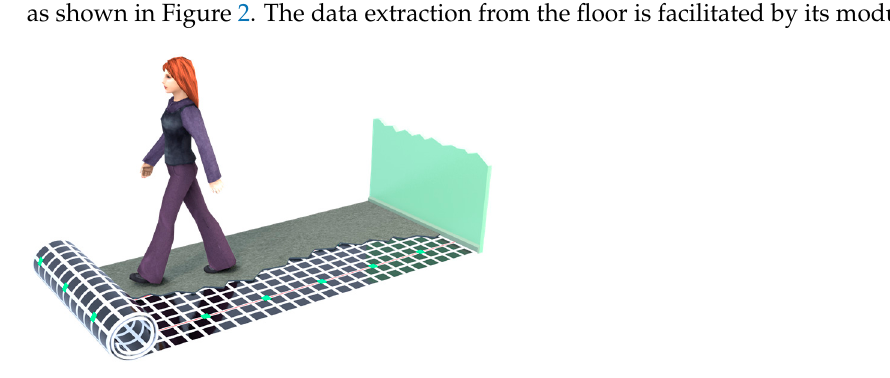
Figure 2. The structure of the capacitive sensing floor. Any non-conductive flooring can be laid on top of the sensing bed.